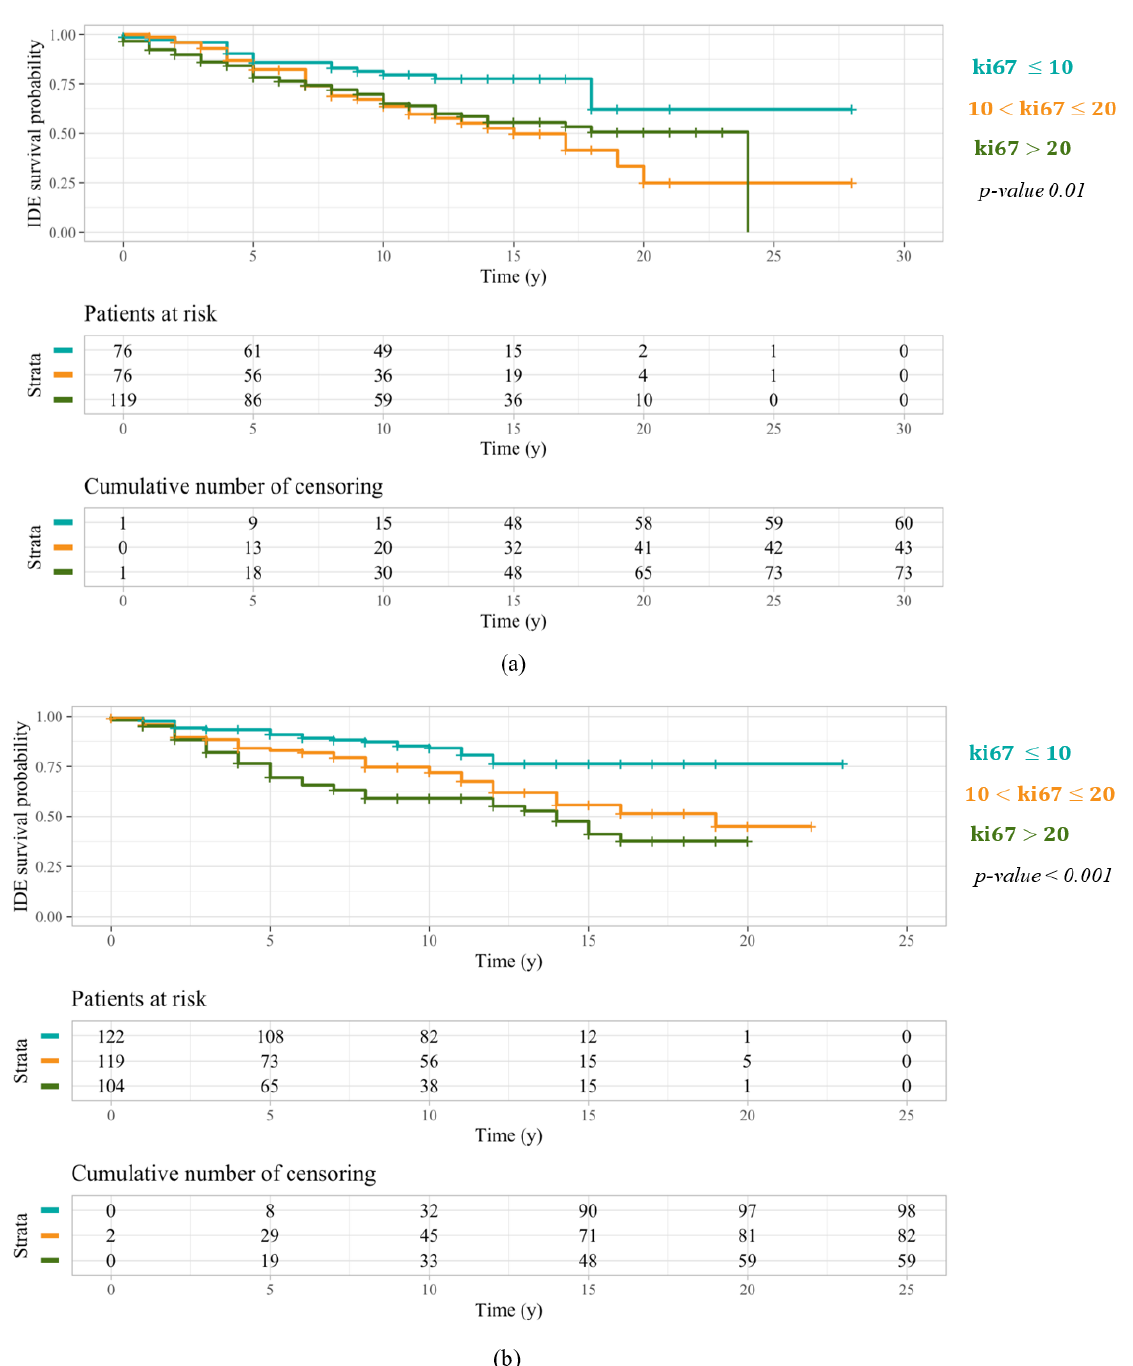
Figure 6. IDEFS curves related to a Kaplan–Meier analysis performed on Luminal-like patients under 50 years old ( a ) and over 50 years old ( b ), both stratified with respect to two ki67 threshold values: 10% and 20%. Luminal-like patients under 50 years old with a ki67 ranging from 10% to 20% showed a long-term IDEFS probability less than Luminal-like patients under 50 years old with a ki67 greater than 20%. On the contrary, Luminal-like patients over 50 years old with a ki67 ranging from 10% to 20% had a long-term prognosis greater than Luminal-like patients over 50 years old with a ki67 greater than